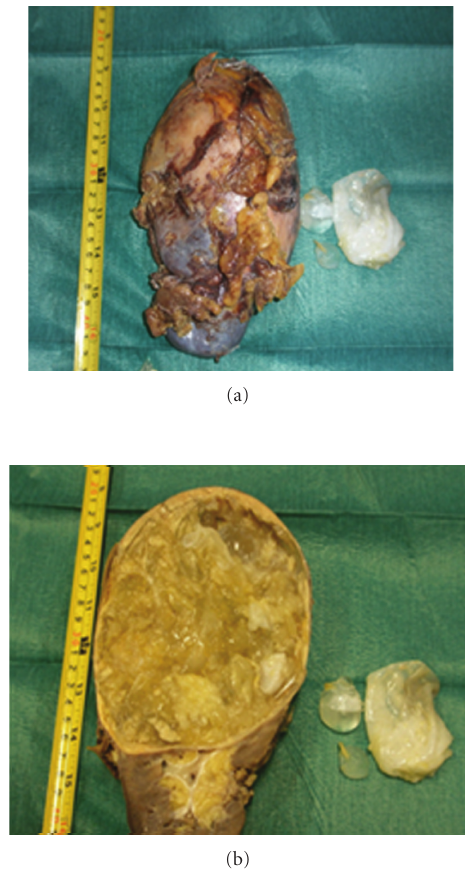
Figure 2: The excised organ (a) and the isolated hydatid renal cyst